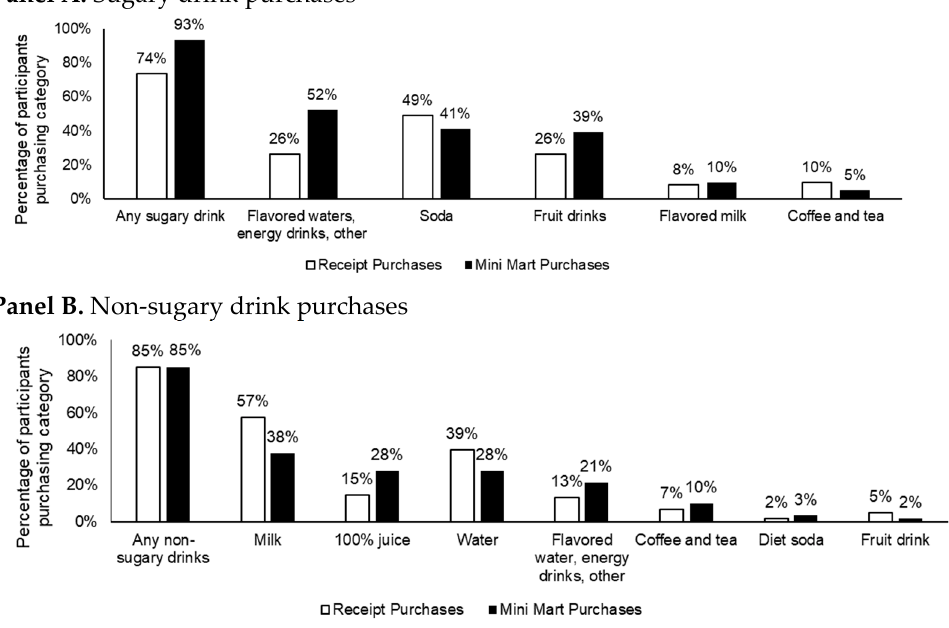
Figure 2. Percentage of participants purchasing each beverage type as measured via receipts. Re- ceipts collected week prior to enrolling in the study and purchases in the UNC Mini Mart (at first study visit).